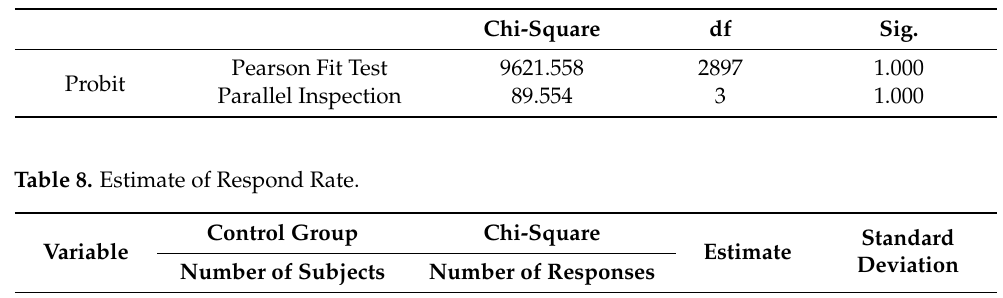
Table 7. Test Result of Chi-Square.